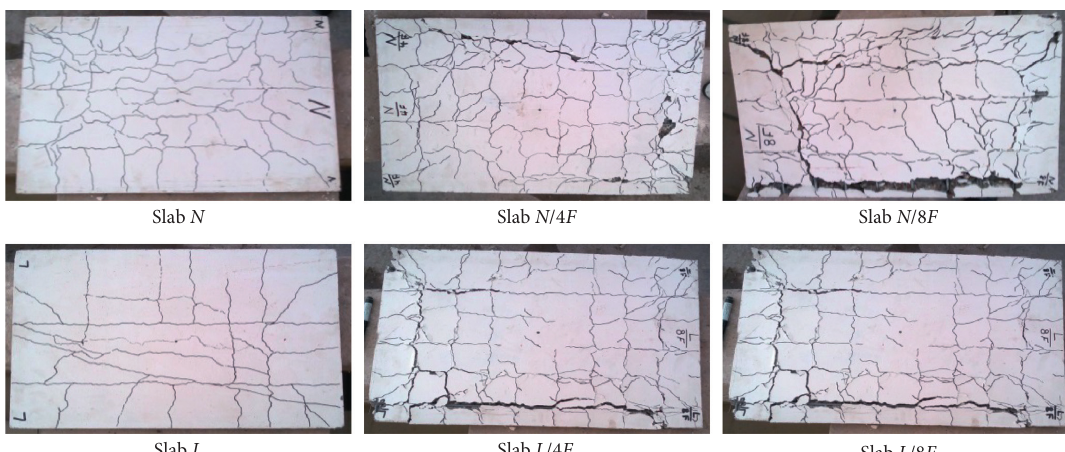
Figure 11: Bottom crack patterns at failure for all concrete